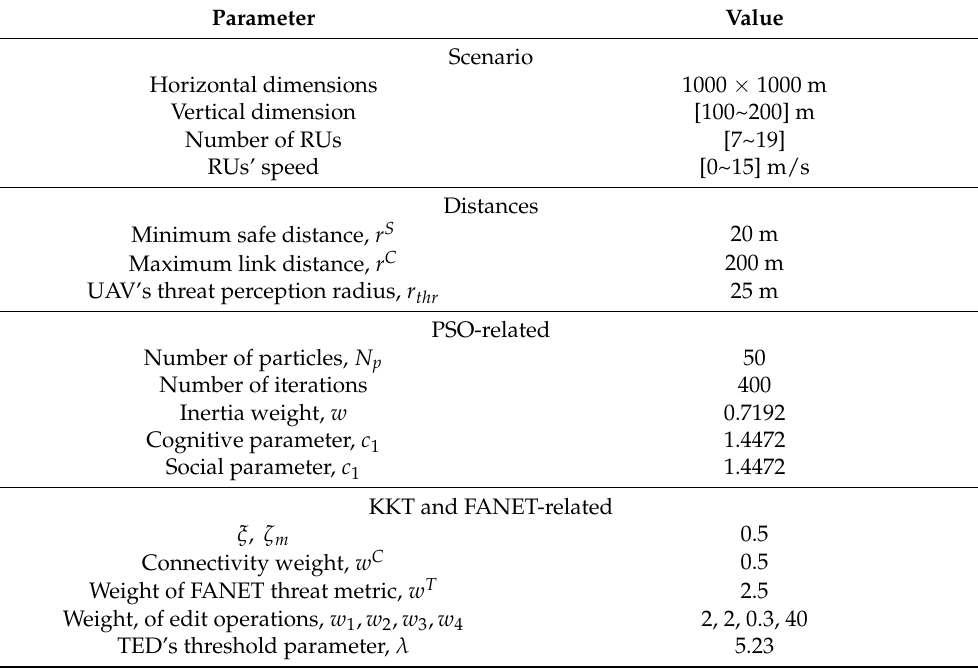
Table 3. Setting of simulation